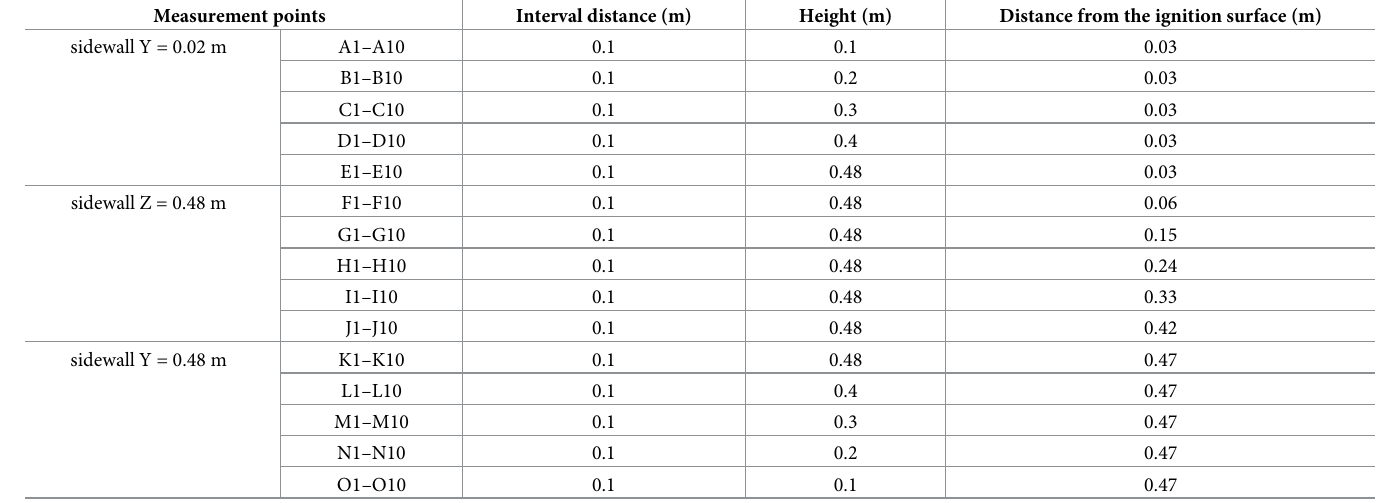
Table 2. Layout of thermocouple trees positioned on the lining inner surface (unit: m). Measurement points